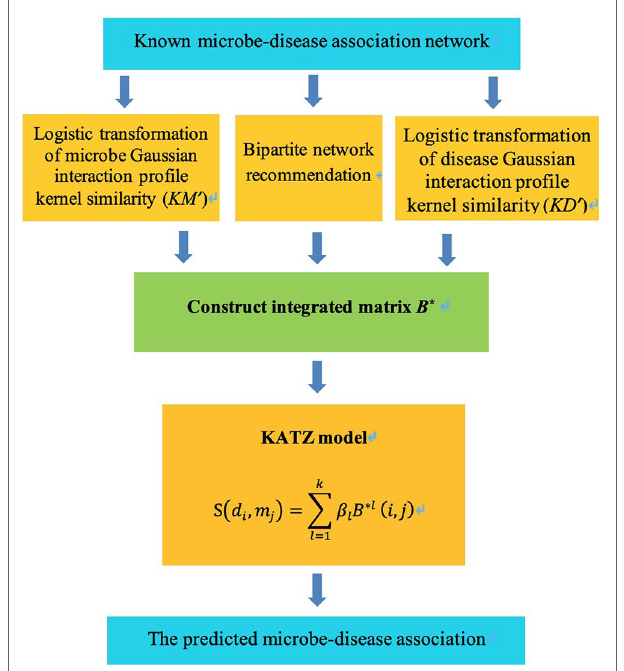
FIGURe 2 | The diagram of